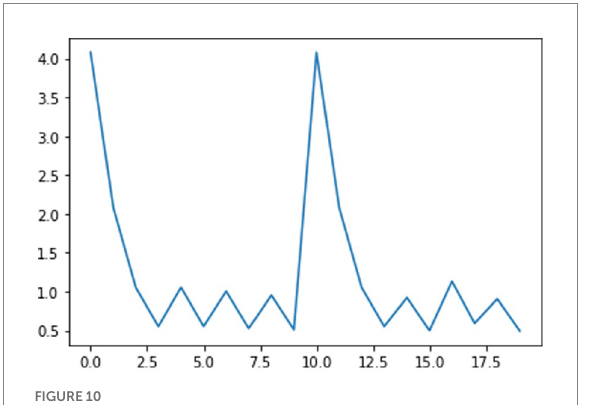
FIGURE 11 ACT-R simulation produces an overall increase in mask wearing as a function of Rt over two simulated waves of